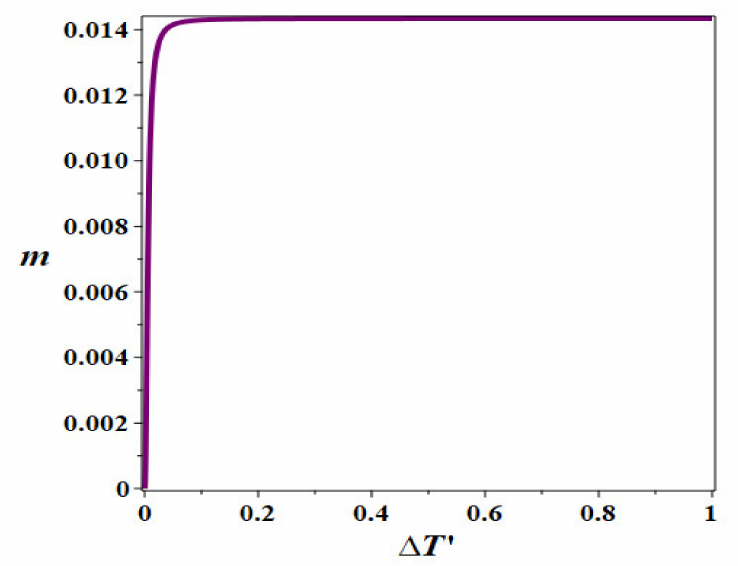
Figure 2. Variation of the mass fraction gradient m according to the temperature difference ∆ T (cid:48) for the binary solution toluene methanol and the thickness e f = 10 − 3